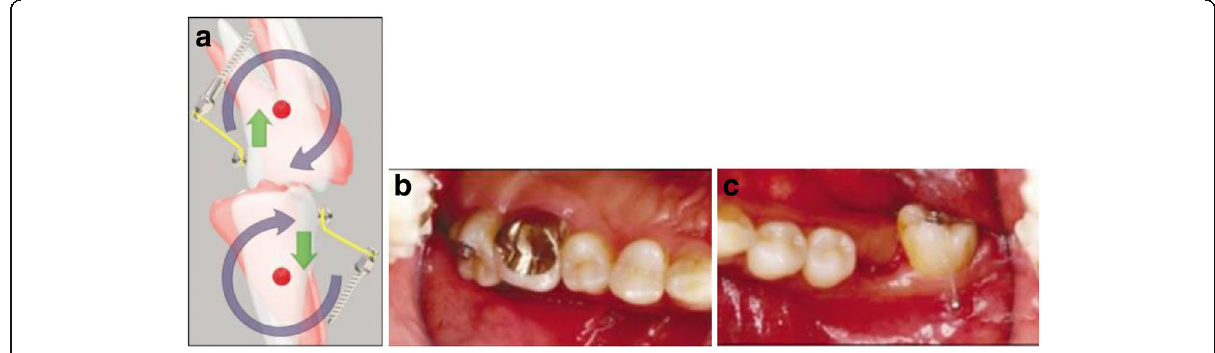
Fig. 9 Uprighting #27 and #37 with miniscrew implants, elastomeric threads, and a temporary bite plane. a Force system used for molar uprighting with mini implants. b Elastomeric thread which was attached from mini implants to buttons bonded to occlusal surfaces of left upper c lower second molar (from Park et al. [28], with kind permission of Journal of Clinical